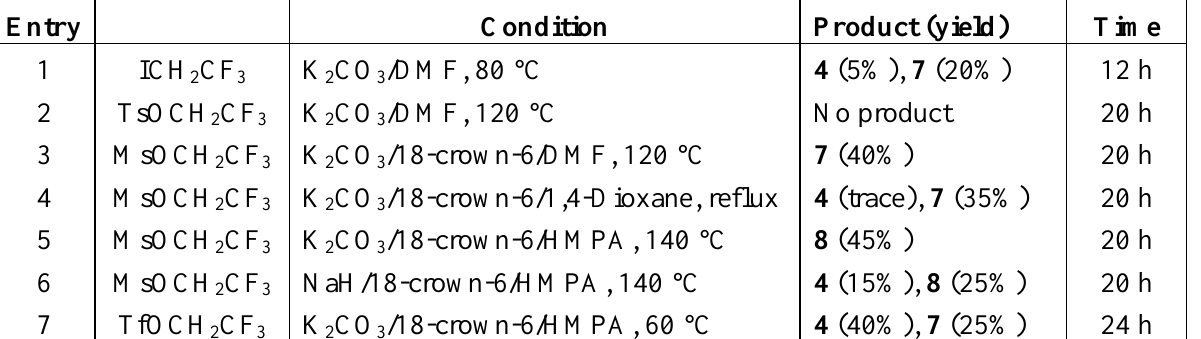
Table 1 . Reactions of compound 5 with different alkylation reagents.